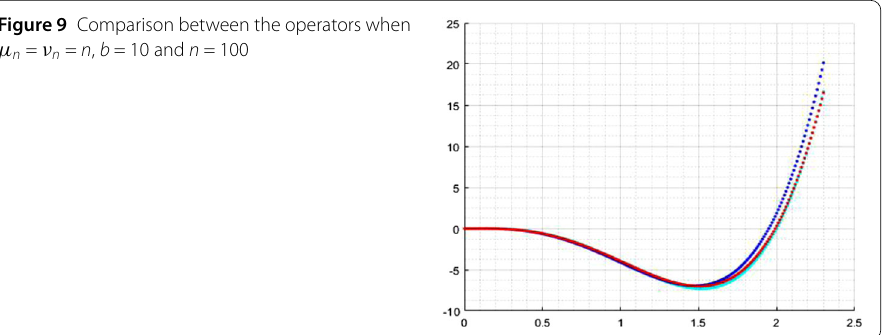
Figure 9 Comparison between the operators when μ n = ν n = n , b = 10 and n =